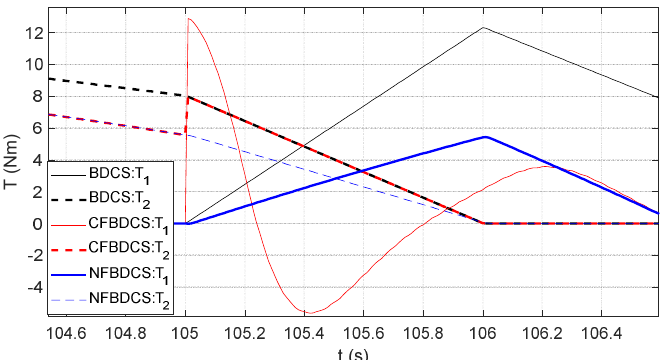
Figure 15. Torque profile from Mode 2 to Mode 1.